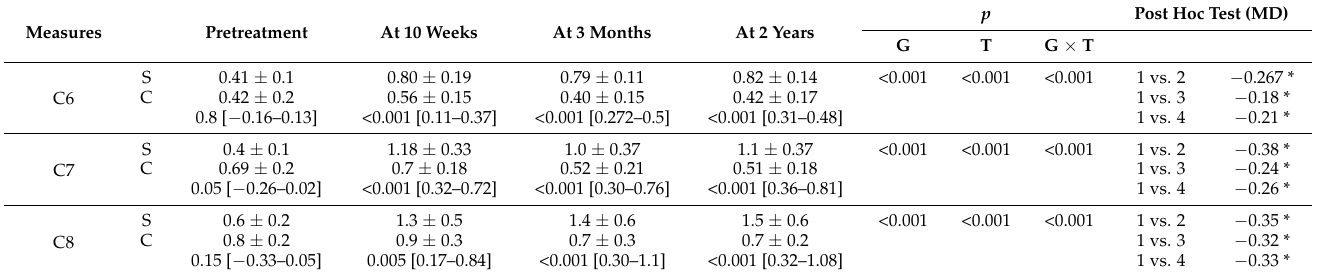
Table 3. The results for the repeated measures one-way analysis of variance (ANOVA) for the DSSEPs amplitudes in the study and control groups for three nerve root levels: C6, C7, and